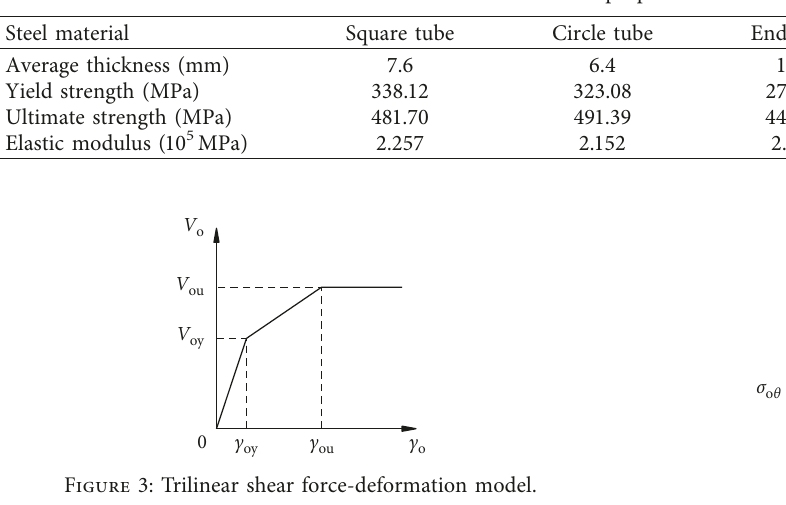
Figure 2: Details of vertical stiffener joints. (a) Transverse profile. (b) Longitudinal profile. Table 2: Material properties of the steel.